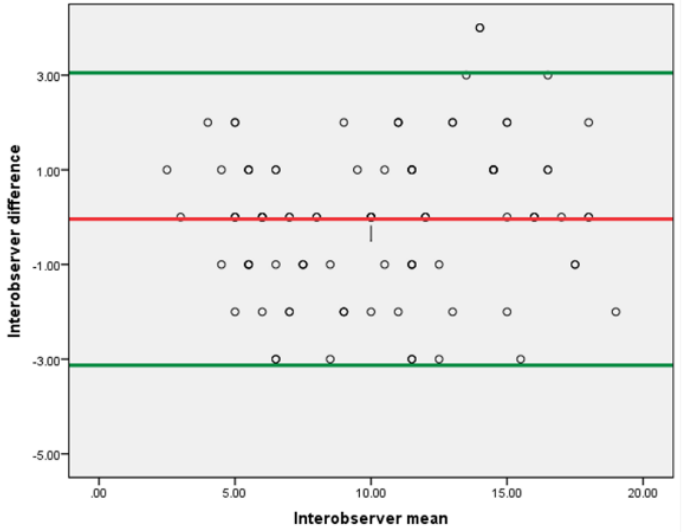
Figure 5. Bland–Altman plot. The Bland–Altman plot shows agreement between the two independent Figure 5. Bland – Altman plot. The Bland – Altman plot shows agreement between the two independ- radiologists. The green lines indicate the 95% limits of ent radiologists. The green lines indicate the 95% limits of agreement.